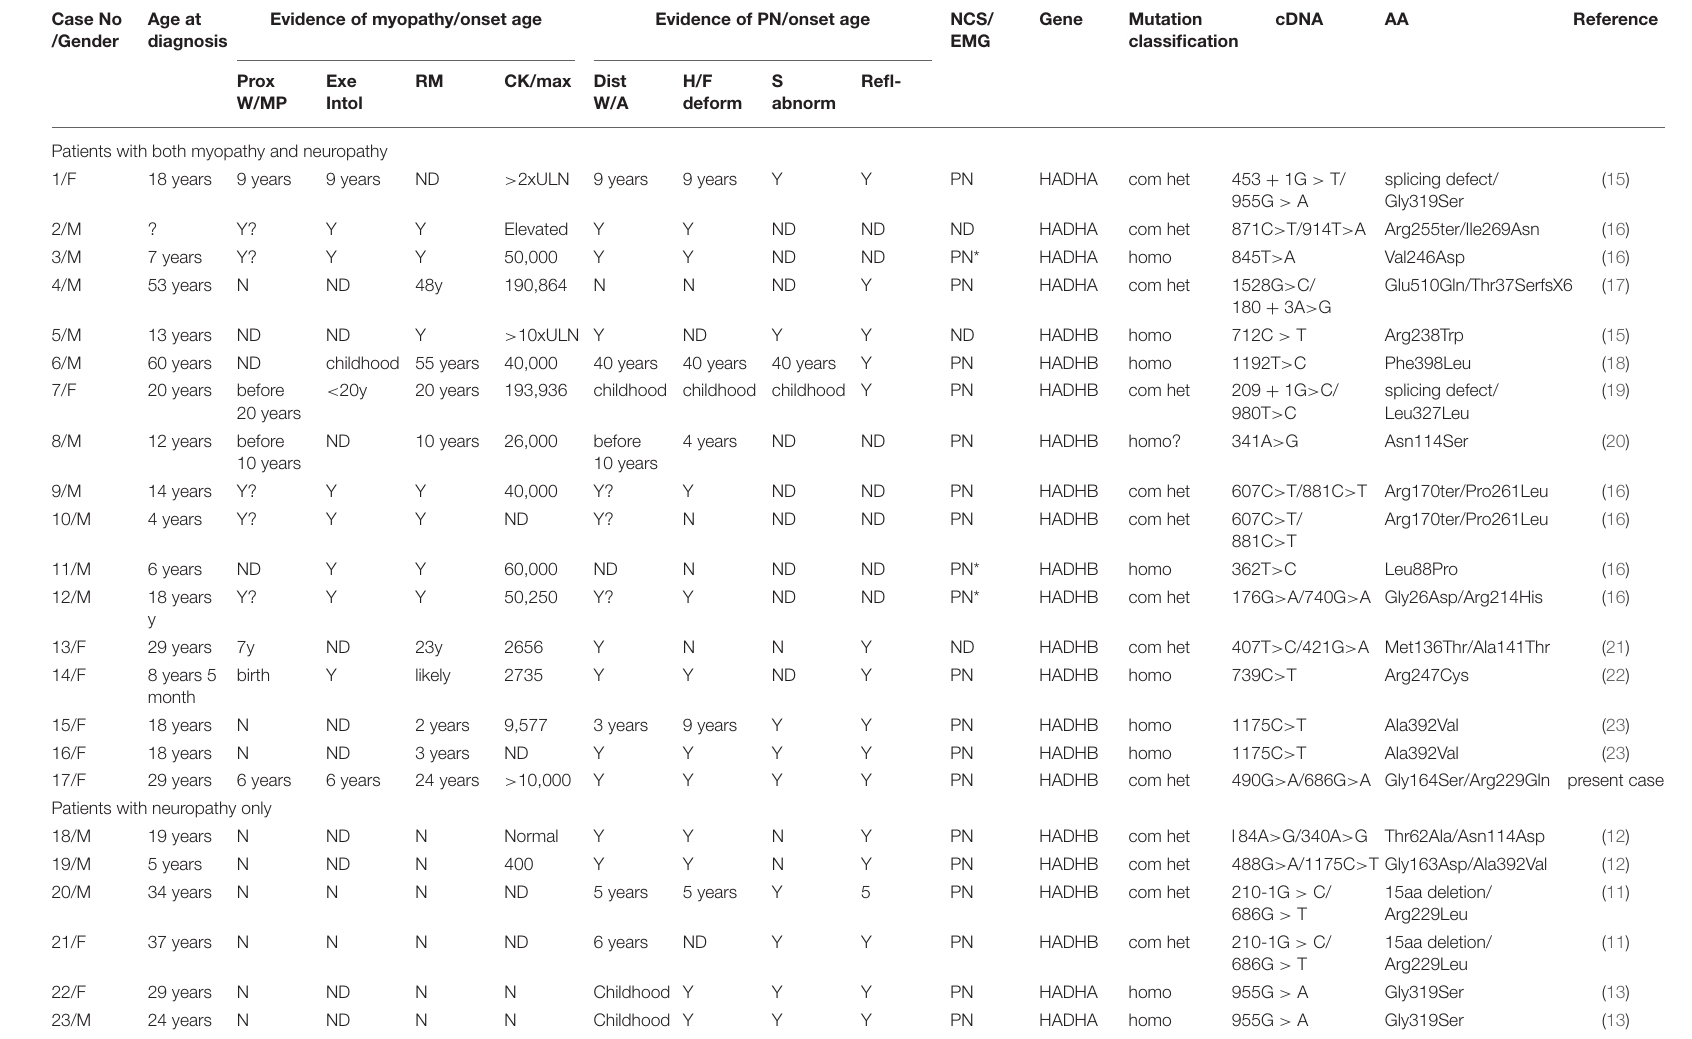
TABLE 1 | Clinical manifestations and gene mutations in neuromuscular MTPD